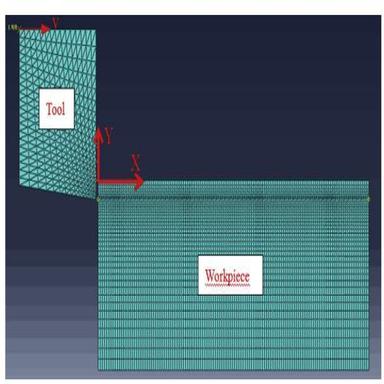
Finite element geometry model of orthogonal cutting.